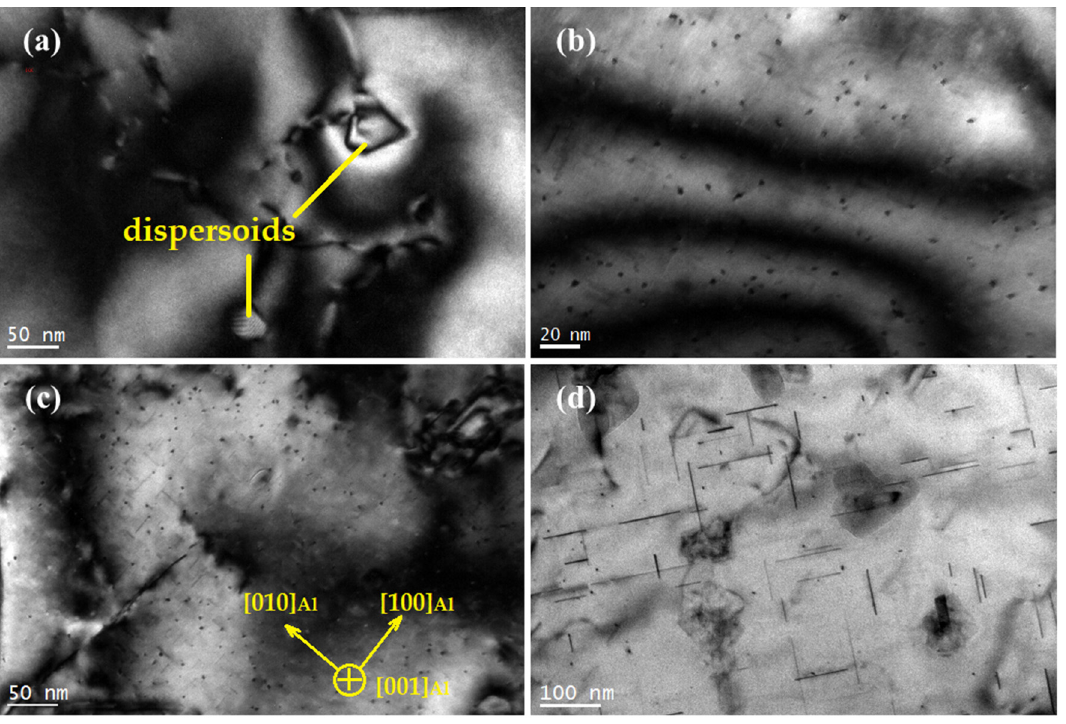
Figure 4. Microstructures of ( a ) as-quenched Al-Si-Mg-Cr-Cu alloy, ( b ) alloy aged for 6 h, ( c ) alloy aged for 12 h, ( d ) alloy aged for 16 h, [ 001 ] Al .